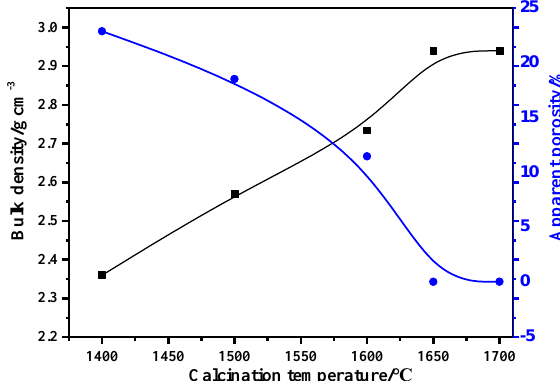
Figure 8. Influence of calcination temperature on properties of mullite.